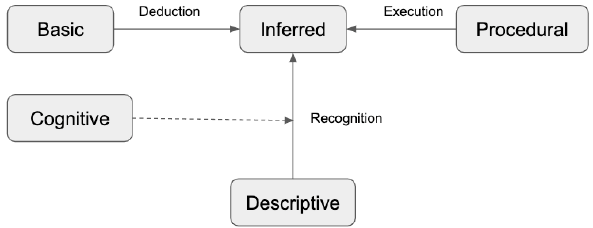
Figure 2. Knowledge types and their